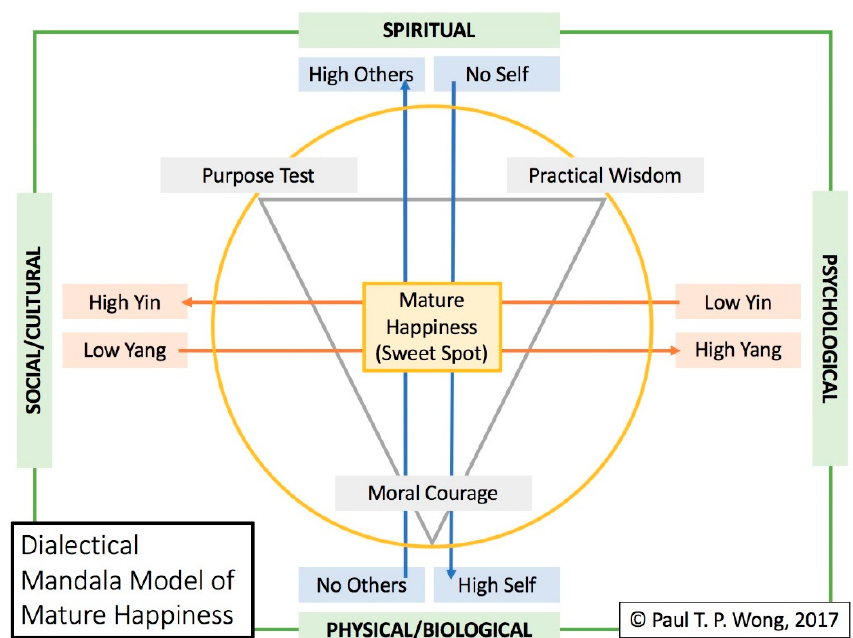
Figure 3. Dialectical Mandala Model of Mature Happiness.